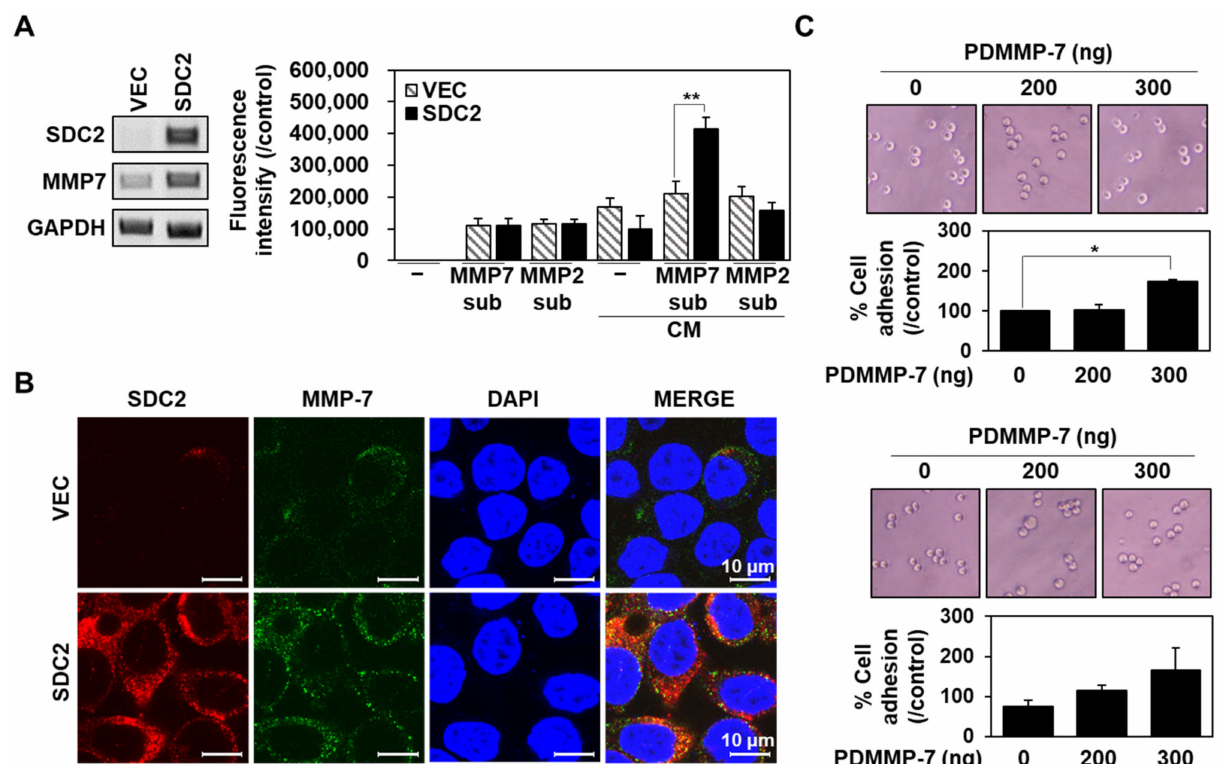
Figure 1. Syndecan-2 mediates the localization of pro-MMP-7 by interacting with the pro-domain of MMP-7. ( A ) HT29 cells were stably transfected with empty vector (HT29-VEC) or a vector encoding syndecan-2 (HT29-SDC2), and the mRNA expression level of sydecan-2 (SDC2) was analyzed by RT- PCR (left). Proteolytic activities of MMP-7 and MMP-2 in the conditioned media (CM) were evaluated by a quenched fluorescence peptide cleavage assay performed using specific substrates (Mca-Pro-Leu- Gly-Leu-Dap(Dnp)-Ala-Arg-NH 2 for MMP-7 and Mca-PLA-Nva-Dap(Dnp)-AR-NH 2 for MMP-2) (right). Fluorescence data were normalized by subtracting values from the control without substrate. Data are shown as mean ± S.D. ( n = 3); **, p < 0.01 versus MMP-7 activity of HT29-VEC. ( B ) Cells were incubated with anti-SDC2 antibody and stained with a Texas-Red-conjugated secondary antibody or incubated with anti-MMP-7 antibody and stained with a FITC-conjugated secondary antibody. Photographs were obtained under confocal microscopy. Scale bar: 10 µ m. ( C ) HT29-SDC2 cells were plated on E-plates pre-coated with gelatin 10 µ g (top) or 0.1% BSA (bottom) with the indicated amounts of His-tagged MMP-7 pro-domain (PDMMP-7). After 4 h, cells were photographed under phase-contrast microscopy, and cell attachment was monitored and plotted using the xCELLigence system. The mean of cell attachment ± S.D. is shown ( n = 3); *, p < 0.05 versus 0 ng of